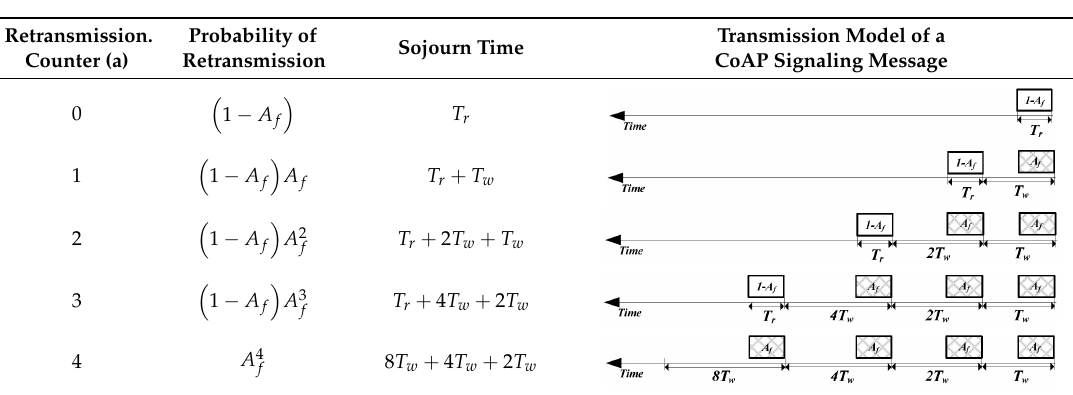
Table A1. Model for the average delay in transmitting a CoAP message.